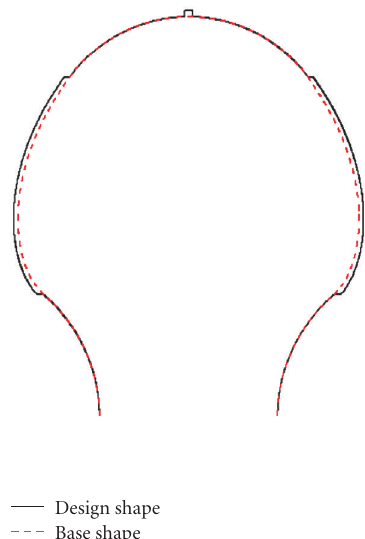
Figure 2: Base shape and design shape.